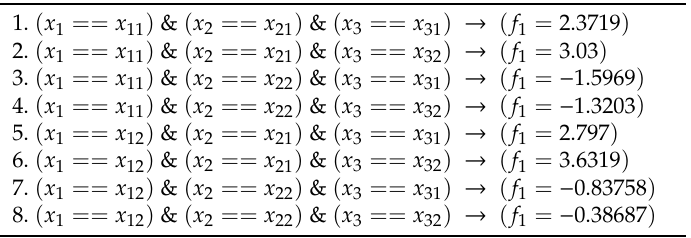
Table 7. Values obtained for function type 1 ( f 1 ) .